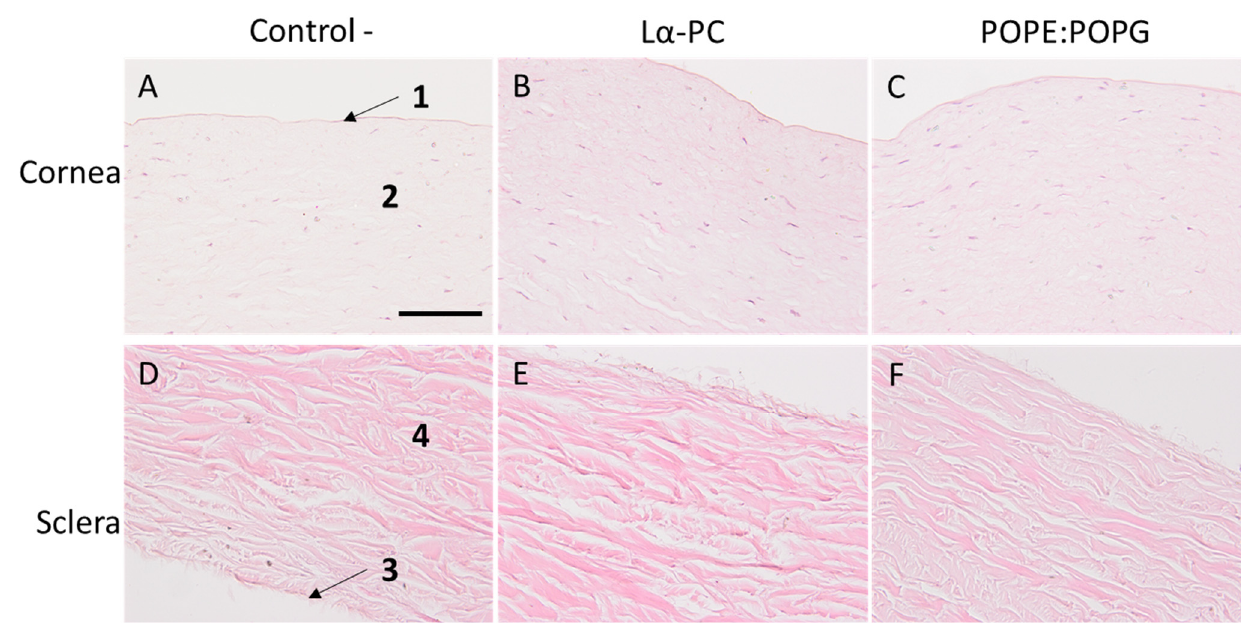
Figure 12. Sclera and cornea sections stained with hematoxylin and eosin. The upper row shows the cornea ( A – C ) and the sclera is shown below ( D – F ) in different conditions: control conditions ( A , D ); L α -PC ( B , E ) and POPE:POPG ( C , F ); (1) corneal epithelium (non-keratinized stratified squamous epithelium); (2) substantia propria; (3) episclera; and (4) stroma. Magnification = 200×, scale bar = 100 μ m.